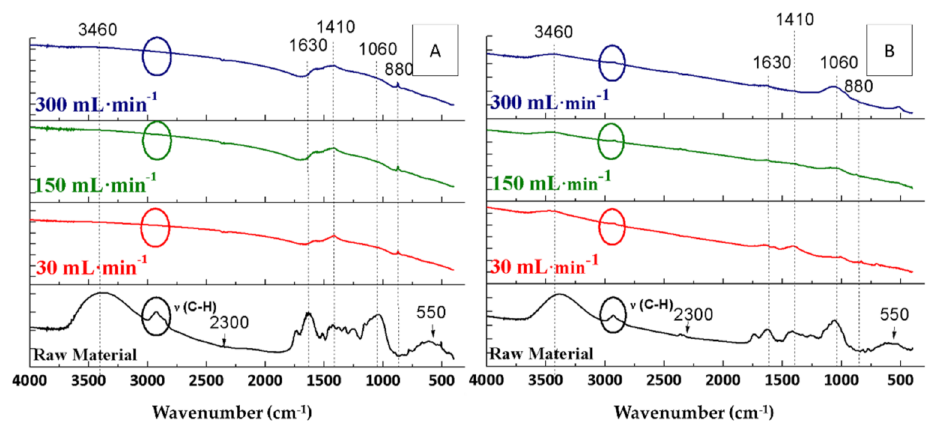
Figure 4. FTIR spectra of the raw materials and the biochars resulting from pyrolyses of orange waste ( A ) and orange pruning ( B ) carried out at 600 ◦ C for 2 h with a heating ramp of 10 ◦ C · min − 1 using different Ar flow